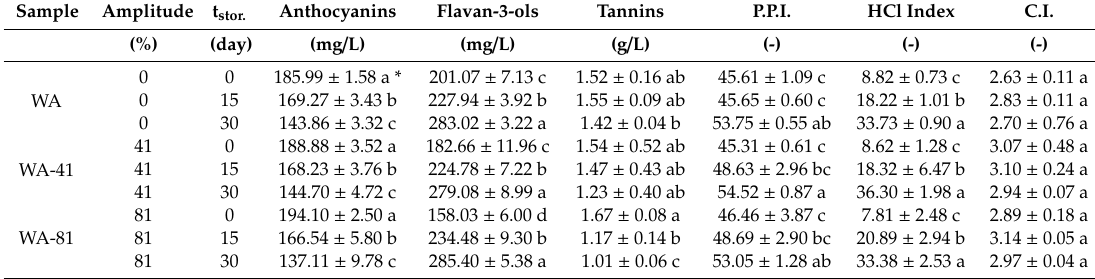
Table 3. E ff ects of ultrasound amplitude and storage time on anthocyanins, flavan-3-ols, tannins content, polymerized pigments index (P.P.I.), HCl index and color intensity (C.I.) of red wine A. Sample Amplitude t stor. Anthocyanins Flavan-3-ols Tannins P.P.I. HCl Index C.I. (%) (day) (mg / L) (mg / L) (g / L) (-) (-)